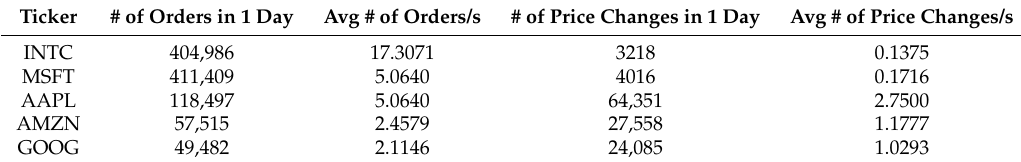
Table 1. Data description and stock liquidity of Apple, Amazon, Google, Microsoft, and Intel.